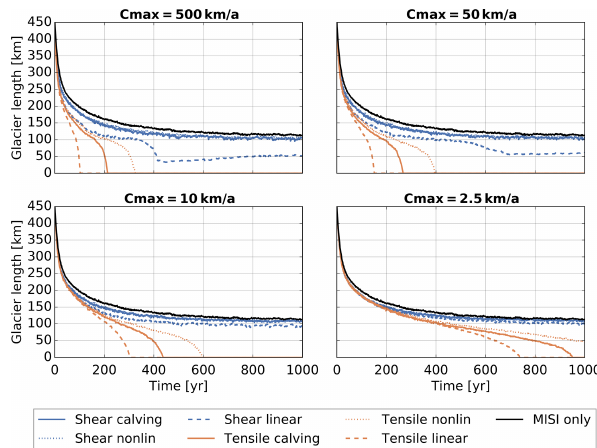
Figure 7. Glacier length time series. Upper left panel shows runs with an upper limit of C max = 500kma − 1 , which is essentially equivalent to the unbuttressed calving rates. Then we have decreas- ing upper limits, and consequently the glacier retreat slows down.